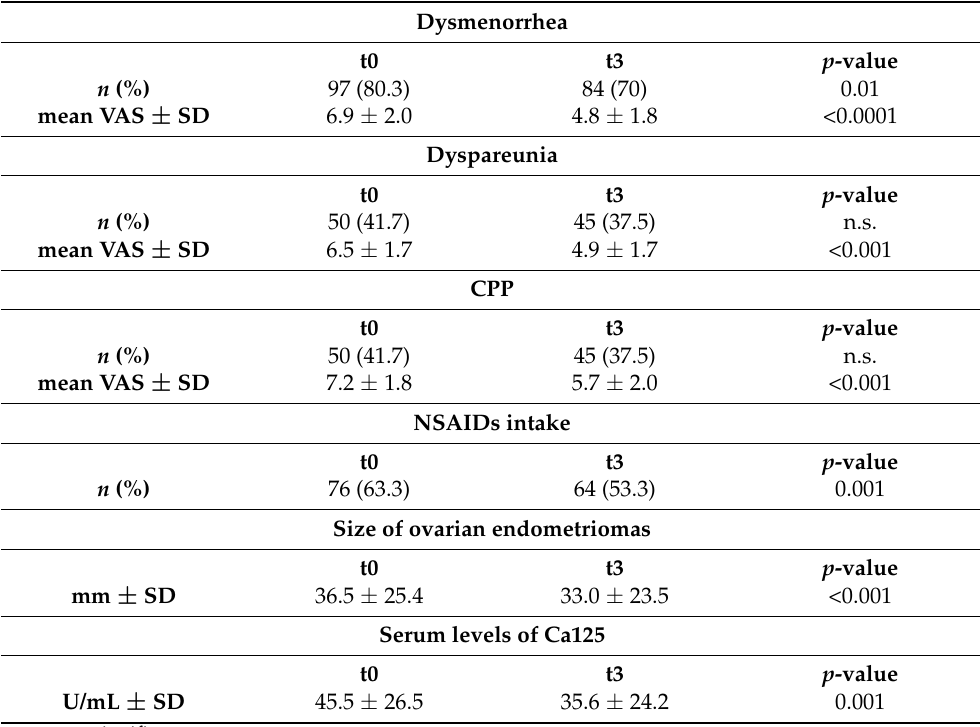
Table 2. Differences in pain symptoms, expressed as dysmenorrhea, dyspareunia and chronic pelvic pain, NSAIDs use, size of ovarian endometriomas and Ca125 serum levels at t0 and t3. Dysmenorrhea t0 t3 p -value n (%) 97 (80.3) 84 (70) 0.01 mean VAS ± SD 6.9 ± 2.0 4.8 ± 1.8 <0.0001 Dyspareunia t0 t3 p -value n (%) 50 (41.7) 45 (37.5) n.s. mean VAS ± SD 6.5 ± 1.7 4.9 ± 1.7 <0.001